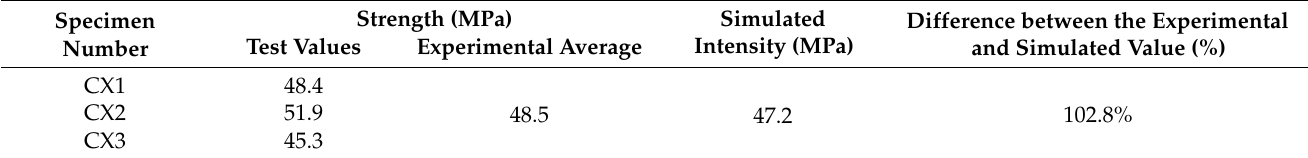
Table 21. Comparative analysis of X-axial compression testing and numerical simulation.